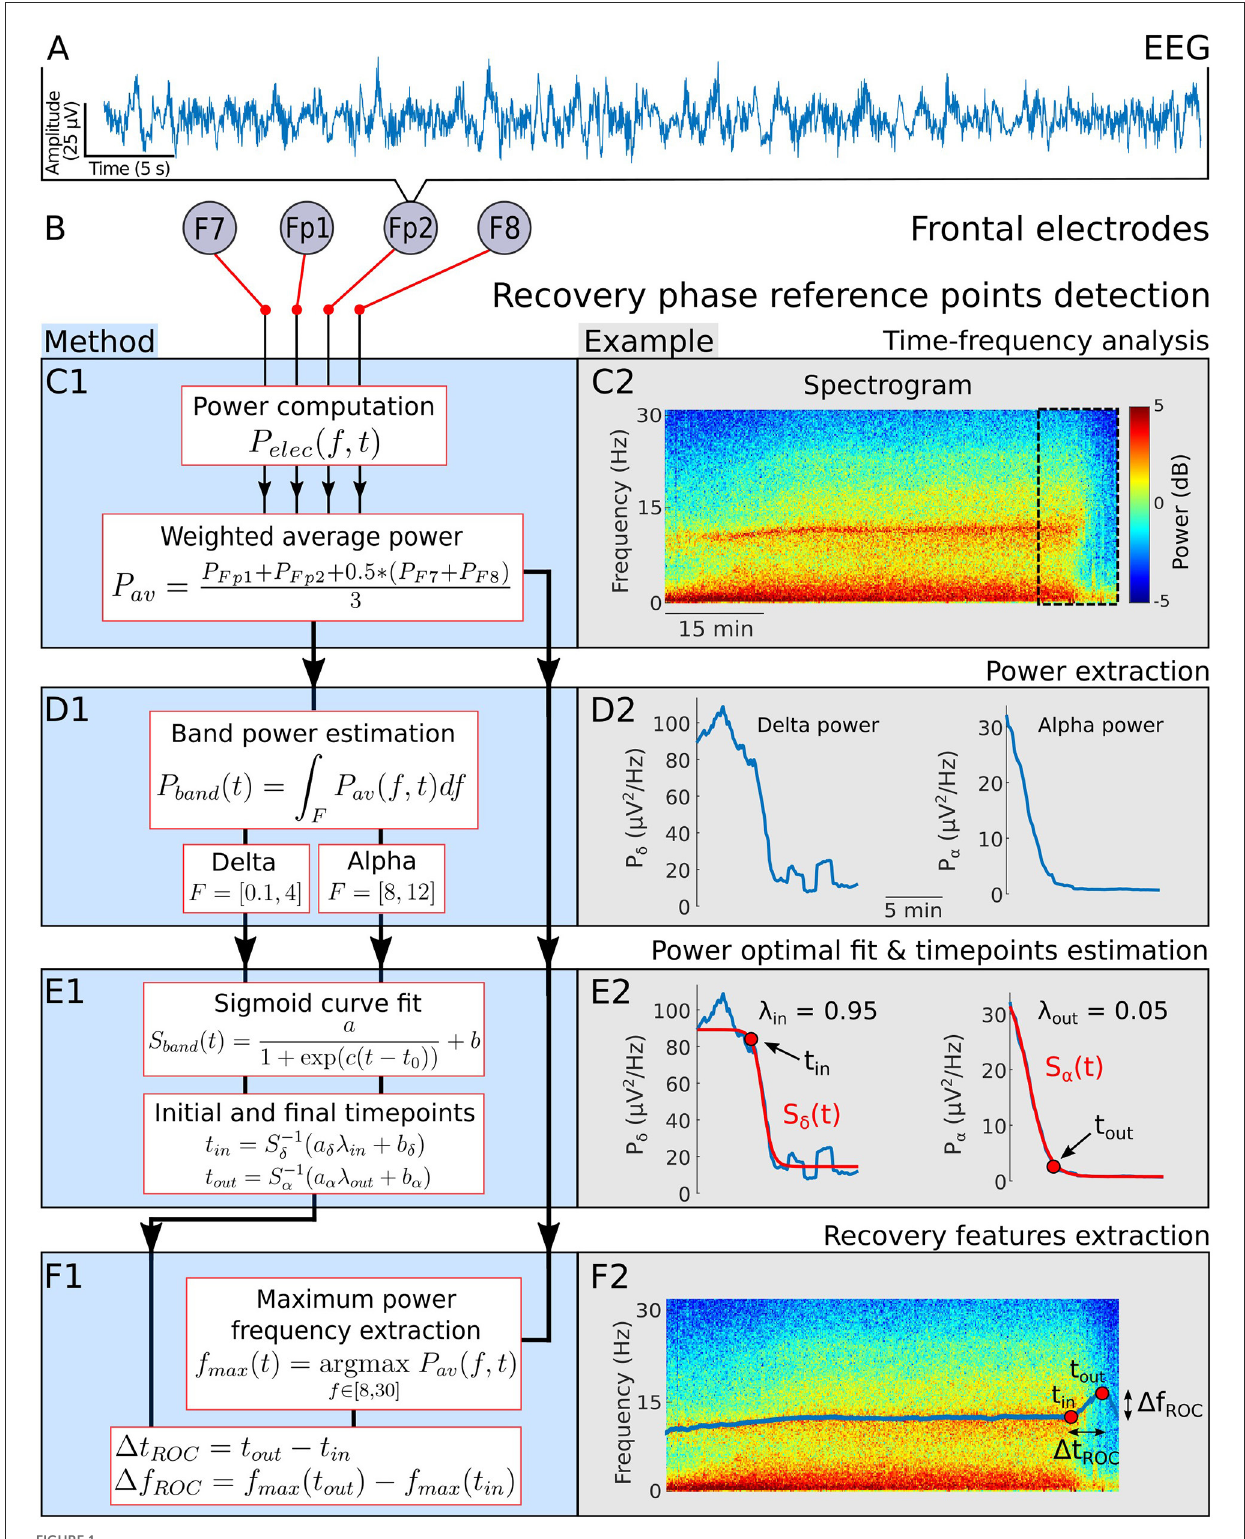
FIGURE1 Emergence phase detection. (A) EEG signal. (B) Frontal electrodes. (C) 1- Power of a weighted average of the four EEG channels. 2- Spectrogram visualization for a single patient during general anesthesia. (D) 1- α − band power P α and δ − band power P δ 2- Power P α and P δ computed from the spectrogram 20 min before the end of anesthesia. (E) 1- Sigmoid function S band used to fit P α and P δ during the recovery phase. Definition of the final time t in (resp. t out ) for which the fit S δ (resp. S α ) reaches for the first time the threshold a λ in + b (resp. a λ out + b ). 2- Fit examples and detection of t in and t out . (F) 1- Maximum power frequency f max and definition of the duration and frequency shifts during recovery. 2- Extracted f max and positioned t in and t out on the associated